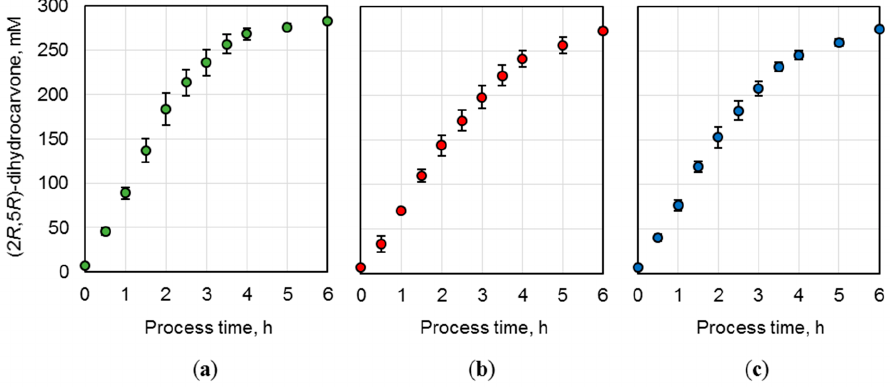
Figure 5. (2 R ,5 R )-dihydrocarvone concentration over process time during batch biotransformation on a 15 mL scale. E. coli BL21 (DE3) whole-cell biocatalysts were applied after expression of ( a ) Loop 1,2a-FDH construct, ( b ) Loop 1,5-FDH construct, and ( c ) Loop 1,5,2a-FDH construct. The reactions were performed with 300 mM ( R )-carvone, 450 mM formate, a biocatalyst cell dry weight (CDW) concentration of ( a ) 40.2 g CDW L − 1 , ( b ) 51.3 g CDW L − 1 , and ( c ) 39.6 g CDW L − 1 . A resin to substrate ratio of 3:1 in sodium phosphate buffer (0.3 M, pH 7.0) at 25 °C. The values are means of three technical replicates ± standard deviations.